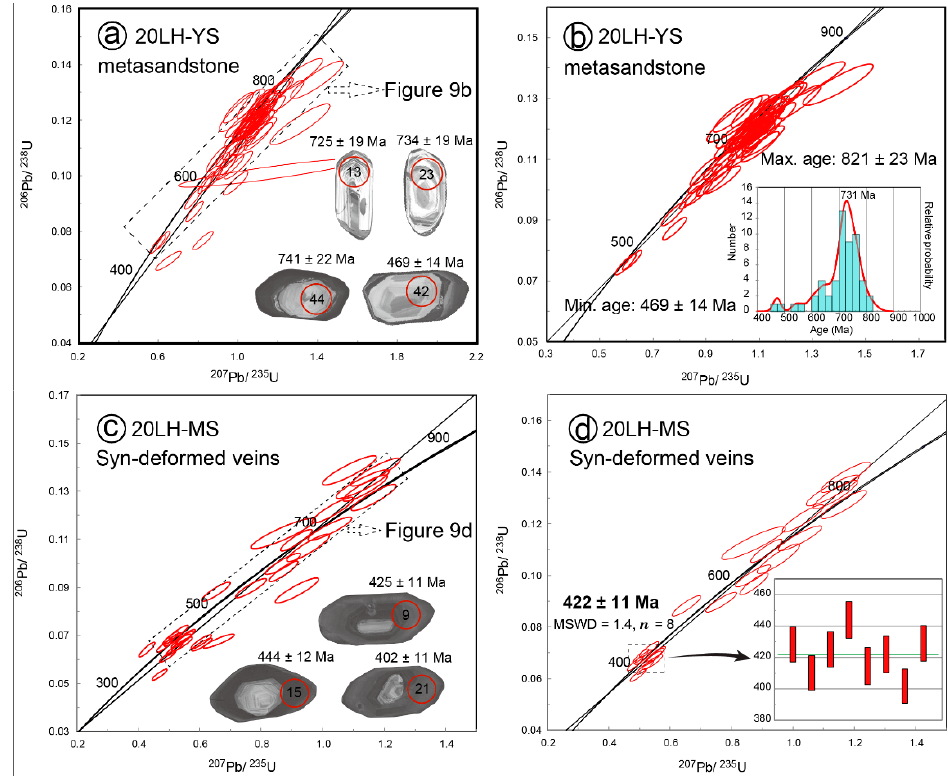
Figure 9. U-Pb Concordia diagrams for samples 20LH-YS (metasandstone) and 20LH-MS (syn-deformed veins). ( a ) Concordia diagram and representative CL images of sample 20LH-YS. ( b ) On or near the concordia curve diagram and age distribution spectrum of sample 20LH-YS. ( c ) Concordia diagram and representative CL images of sample 20LH-MS. ( d ) On or near the concordia curve diagram and weighted average age diagram of sample 20LH-MS.